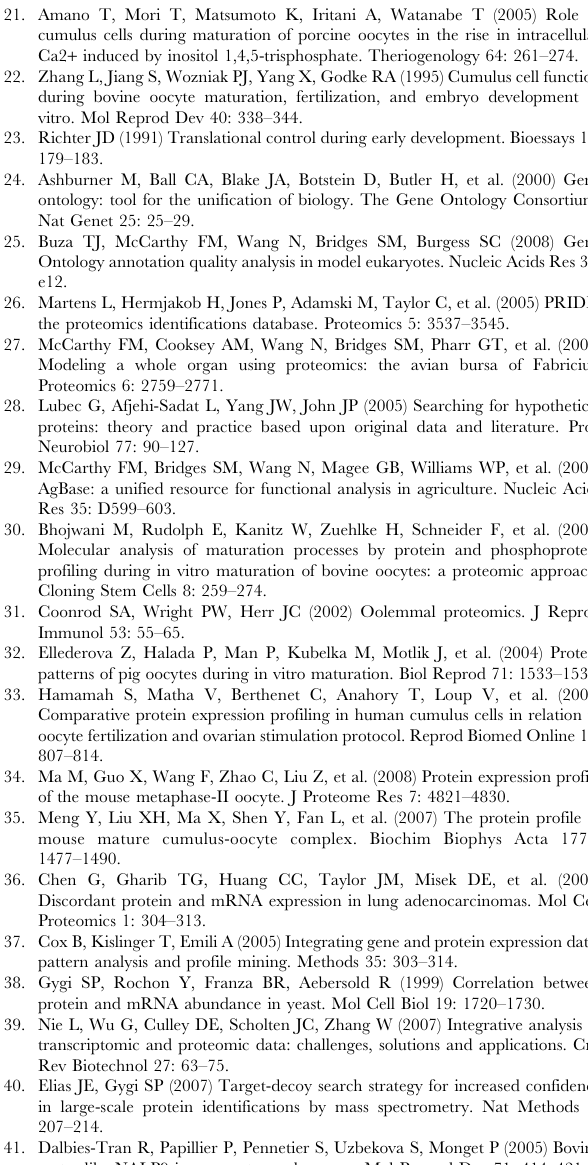
Table S4 Proteins involved in cell-to-cell signaling biological